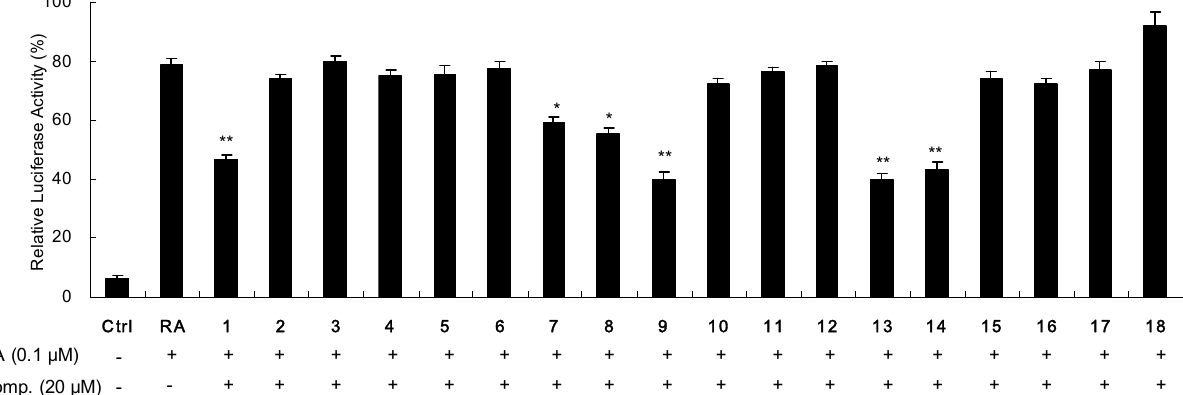
Figure 4. Inhibitory effects of isolated compounds on reporter transcription activities of RXR α .